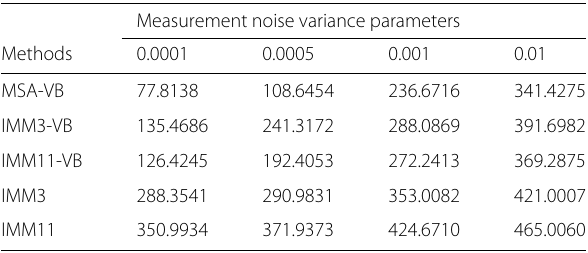
Table 4 Average RMSEs in position with different measurement noise variance parameters for the experiment 2 Measurement noise variance parameters